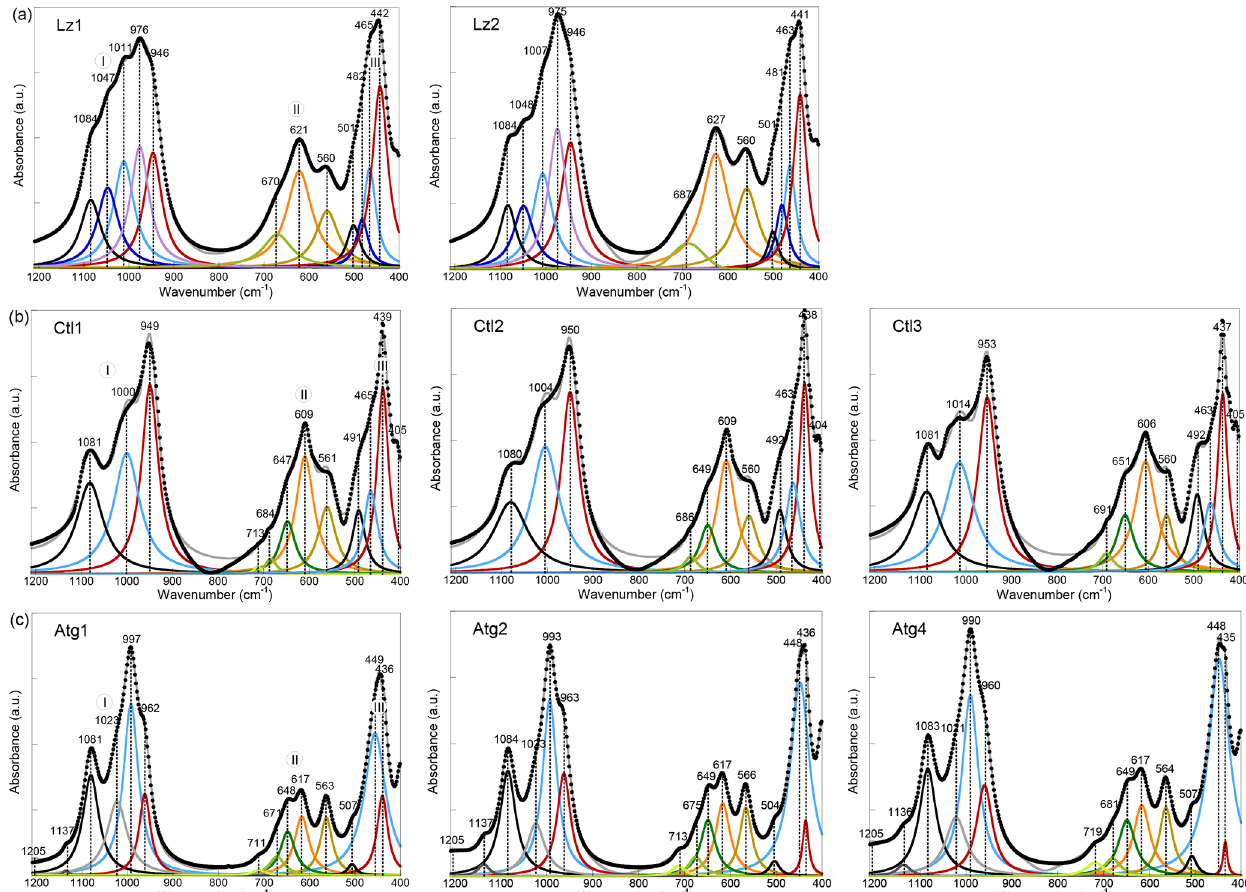
Figure A1. MIR spectra in the 1200–400cm − 1 range (lattice transitions) of (a) lizardite (Lz1, Lz2), (b) chrysotile (Ctl1, Ct2, Ct3), and (c) antigorite (Atg1, Atg2, Atg4). The spectra have been decomposed into individual components using Lorentzian functions. Black dots: experimental data. Solid grey line: best fit. (I) Si–O stretching vibrations, (II) libration and hindered translation of OH groups, and (III) Si–O bending